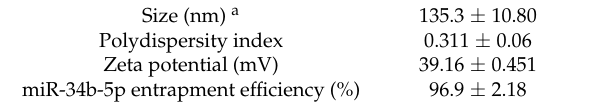
Table 1. Characterization of miR-34b-5p-loaded PEGylated lipid